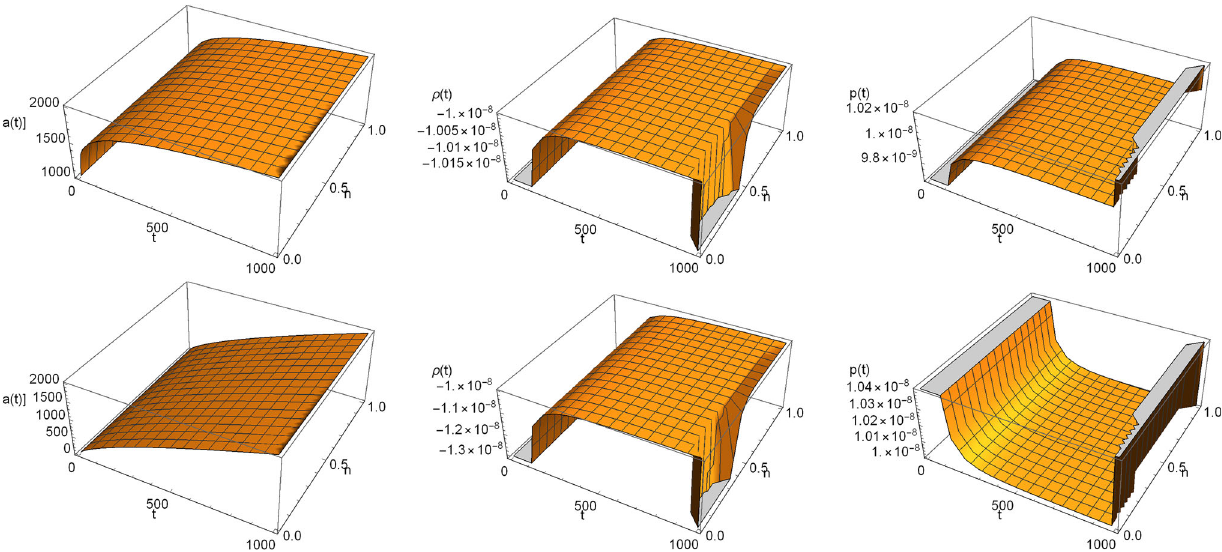
Fig. 3 The evolution of the scale factor a ( t ) , density ρ( t ) and pressure p ( t ) for typical values of q = 0 . 2 in the upper plot and q = 0 . 8 in the lower plot. We have set a s = 2000 , a ES = 0 . 01 , t s = 1000 , λ = 1 , S = 0 . 01 and k = − 1. We see that by increasing q value, the slopes